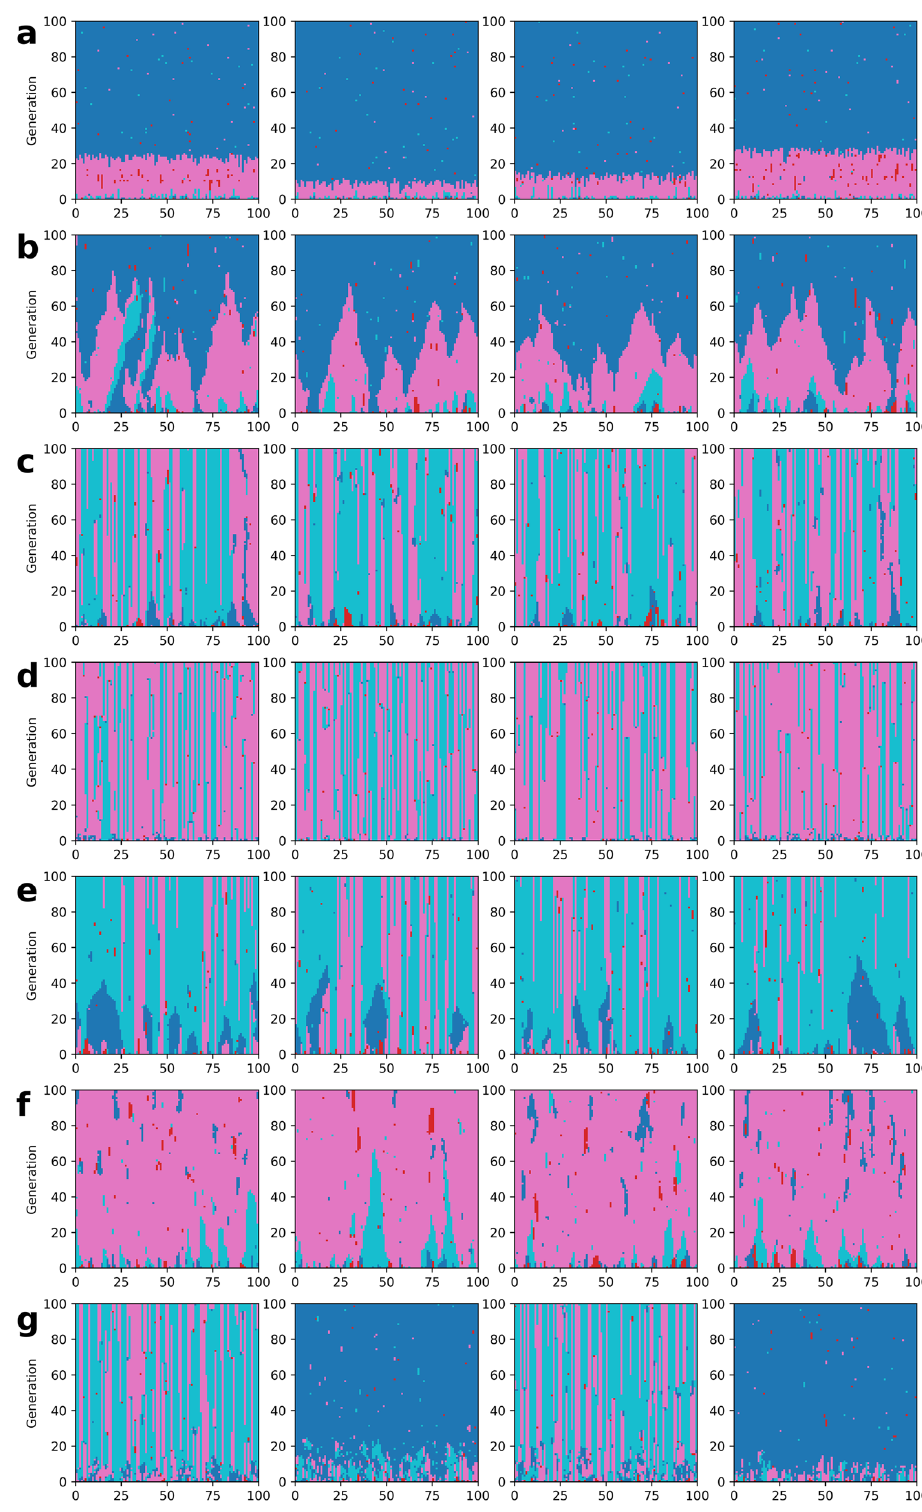
Figure 2. Transition diagram of strategy in 100 generation. From the top, each row is a case of different values of ( g , p , a ): (a) (1, 1, 1), (b) (0.5, 0.25, 0), (c) (0, 0, 0), (d) (0, 0, 1), (e) (1, 0, 0), (f) (0, 1, 0) and (g) (0.5, 0, 0.5). In each row, 4 trials are shown with different random seeds on the same parameter set. In each panel, all 100 agents are in a queue of a row. The horizontal axis corresponds to agent’s id. Agents with consecutive numbers are next to each other on the regular network. For example, the agents next to an agent having id = 24 are id = 23 and id = 25 . Agents of id = 99 and id = 0 are next to each other. In each graph, the lowest row shows their strategies at the first generation. Also, the second row shows those at the second generation, while the most top row shows those at the 100-th generation. An agent whose strategy is CP is colored in light blue, CN in pink, DP in red, and DN in dark blue. Parameters are ( N , n ) = ( 100, 4 ) , ( b , c , f , s ) = ( 2, 1, 6, 3 ) , and µ = 1% . This image is made by using Python 3.7.2 (www. python.